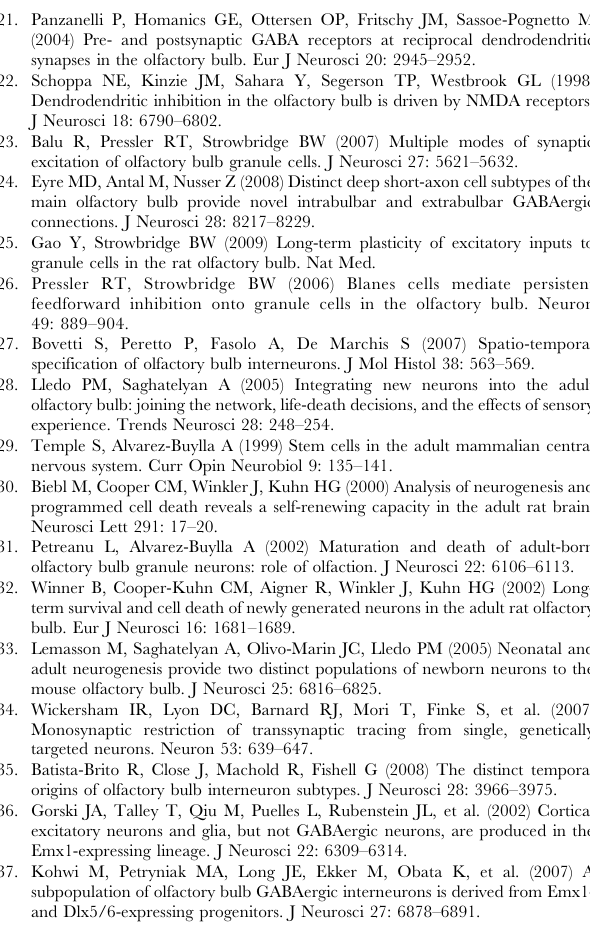
Figure S5 Blockade of Synaptic Activity Does Not Affect Rabies Virus Transfer. (a)–(e) Monosynaptic labeling in cultured olfactory bulb slices made from mice electroporated in vivo with a plasmid encoding tdTomato, Rabies G, and TVA, followed by in vitro infection with SAD D G-EGFP and treatment with pharmacological blockers of synaptic activity. In all slice conditions, granule cells susceptible to RV infection are